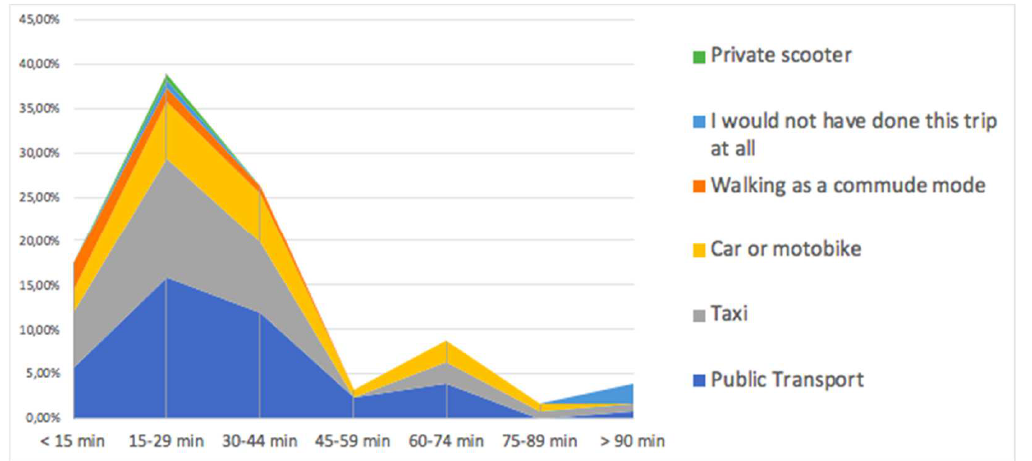
Figure 7. The last car-sharing trip: frequency of duration and alternative modes (N = 126, % of all car-sharing users). In the figure, “Taxi” includes traditional taxis and TNC.